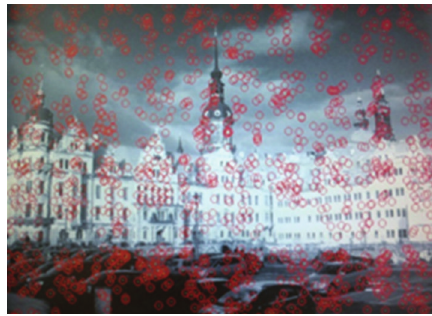
Figure 9: SIFT descriptors marked in output